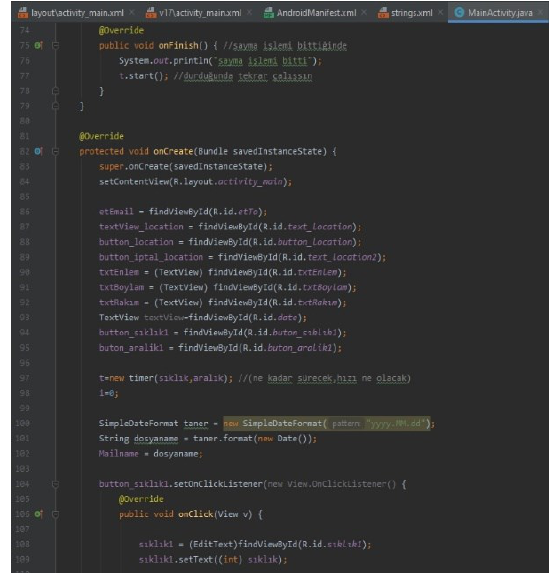
Figure 2. Coding example of the 'Location Every Second' App.